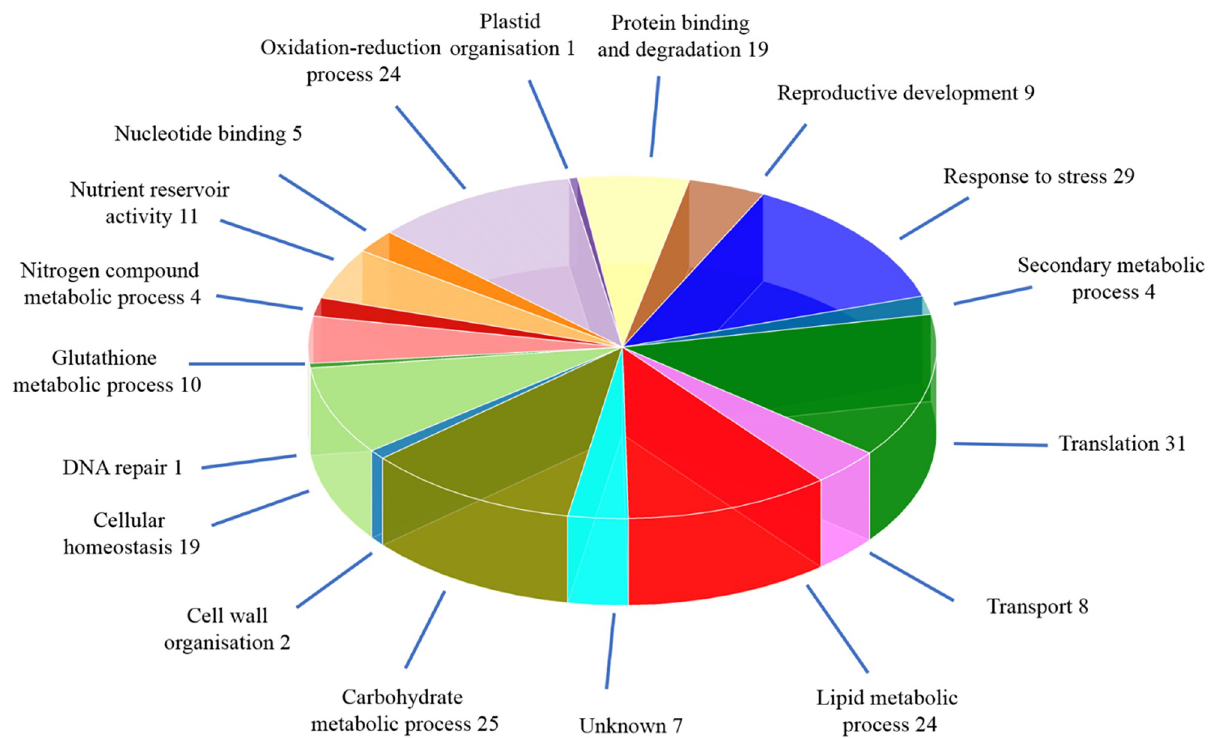
Fig 4. Distribution of proteins identified from Brassica rapa R-o-18 seed extract according to GO molecular function annotations. The proteins identified from B . rapa R-o-18 seed extract using LC-MS/MS were categorized based on Gene Ontology (GO) annotation as described in Material and Methods. Seventeen ‘molecular function’ categories were assigned to 226 proteins with 7 unknown proteins remaining uncategorized.